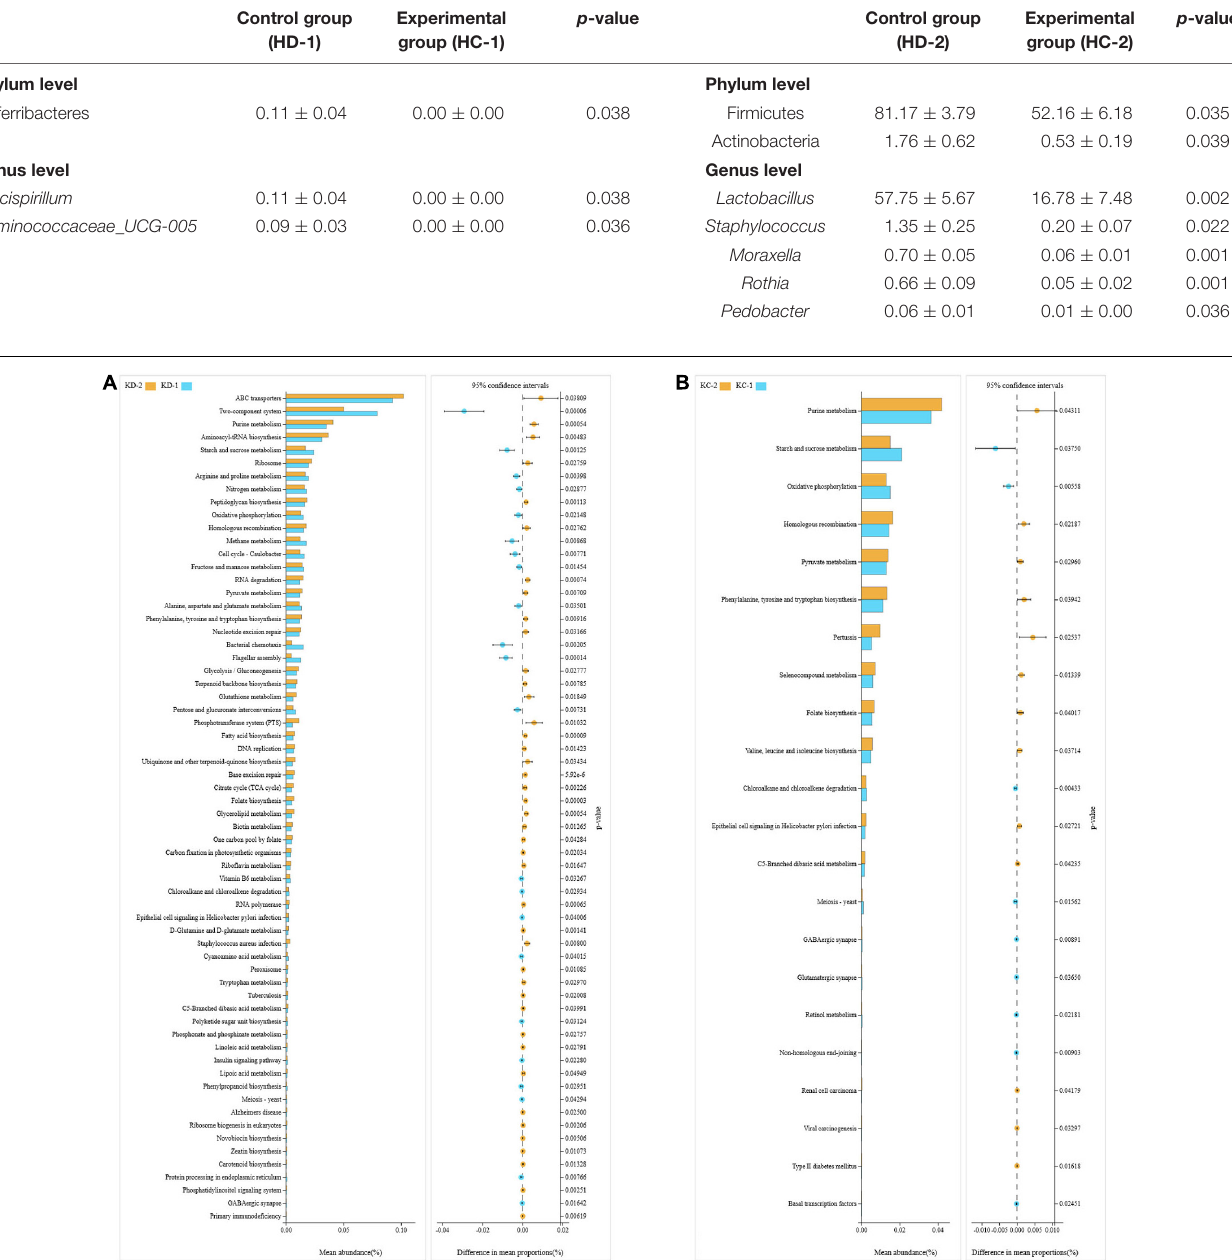
FIGURE 3 | KEGG pathways for bacteria in jejunal meconium of neonatal piglets before suckling. KD-1: bacteria of jejunal meconium of Hoxa1 − / − neonatal piglets from the control group. KD-2: bacteria of jejunal meconium of non-Hoxa1 − / − neonatal piglets from the control group. KC-1: bacteria of jejunal meconium of Hoxa1 − / − neonatal piglets from the experimental group. KC-2: bacteria of jejunal meconium of non-Hoxa1 − / − neonatal piglets from the experimental group. (A) Control group. (B) Experimental